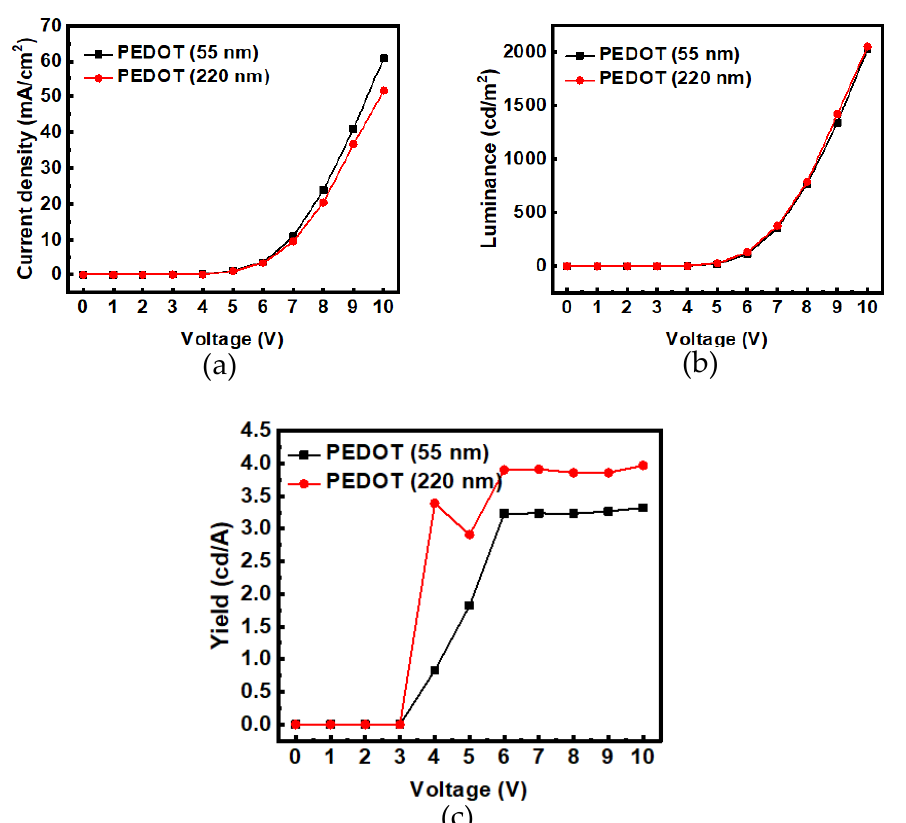
Figure 6. The comparisons of characteristic curves of thick HIL with thinner HIL: ( a ) I−V, ( b ) L−V, and ( c ) η−V .